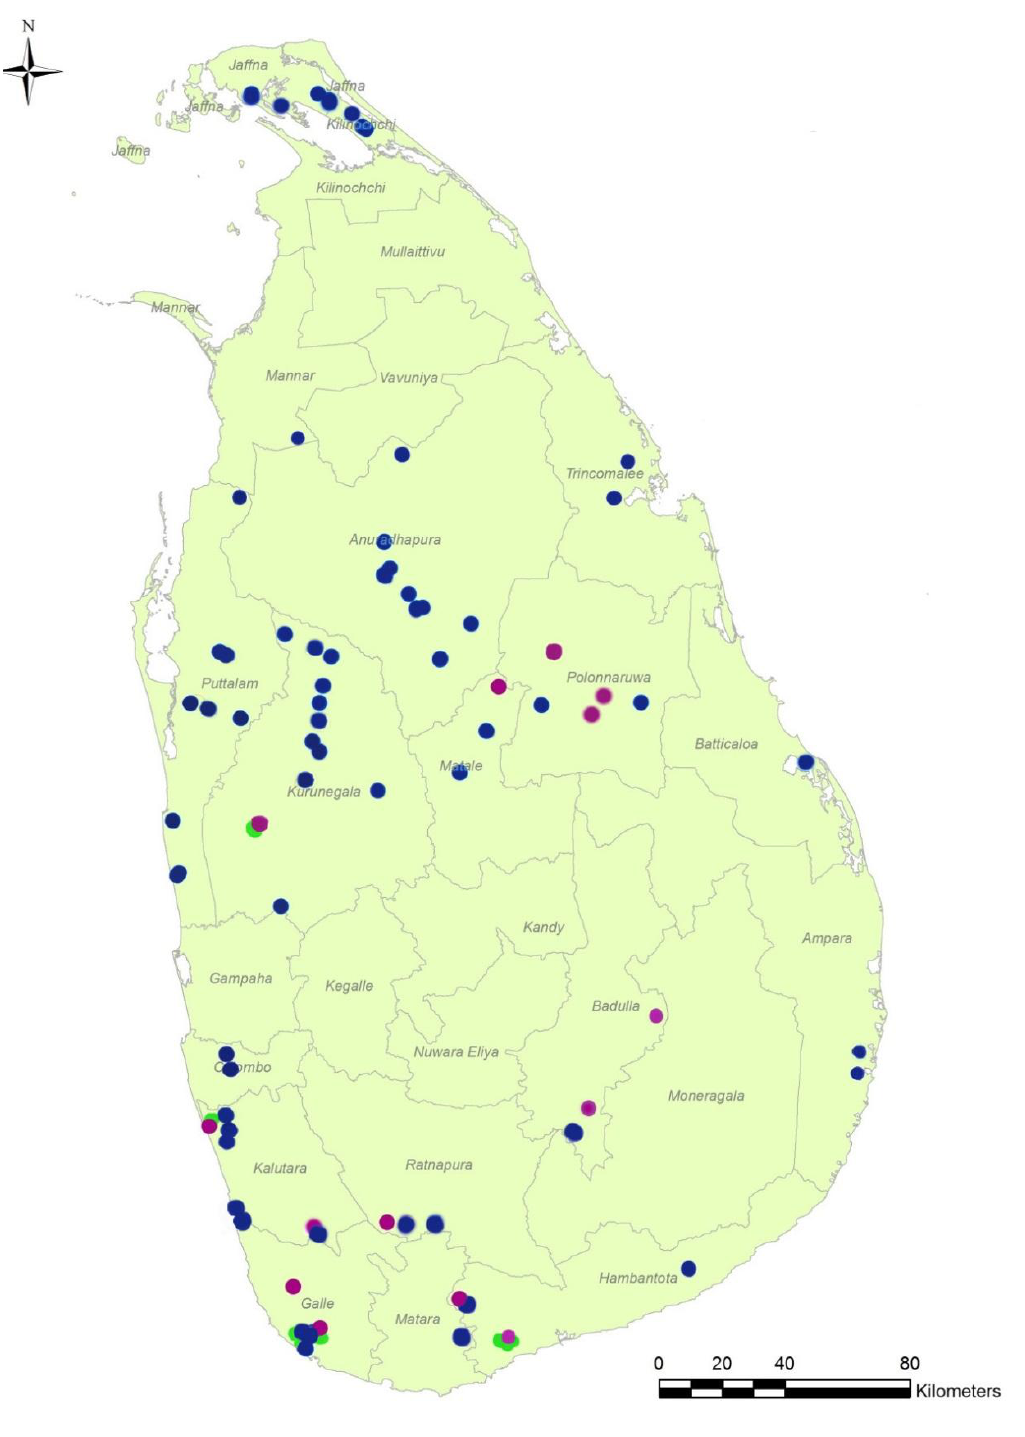
Figure 2: Map of Sri Lanka depicting the locations where the samples were collected in the present